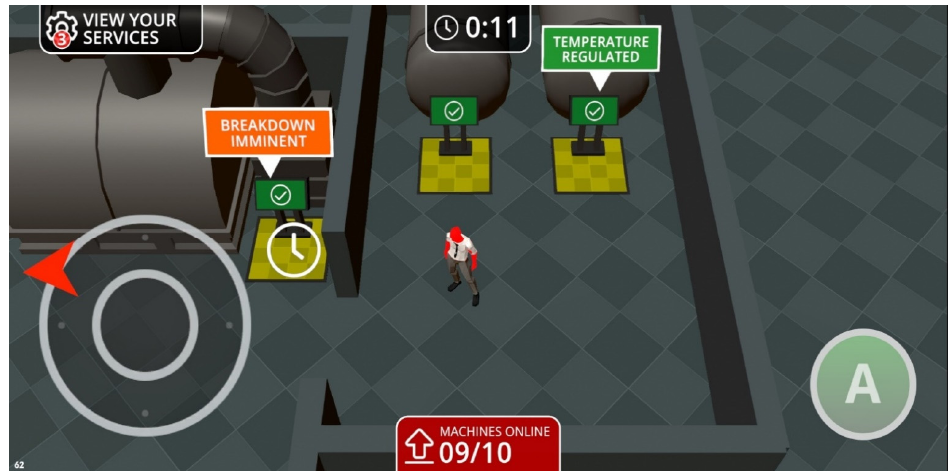
Figure 4. Screen capture of the Prototype Howden DEAS game (Android device).